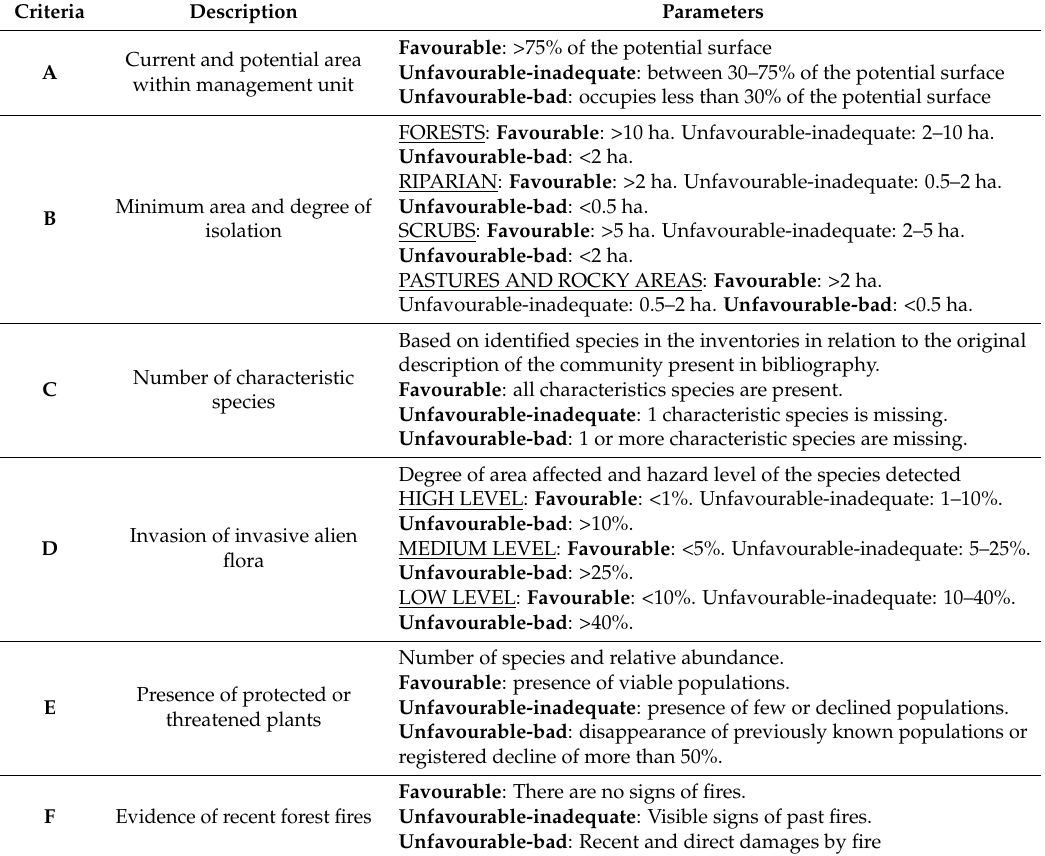
Table 3. List of criteria used in the assessment phase. Description and parameters used for the proposed